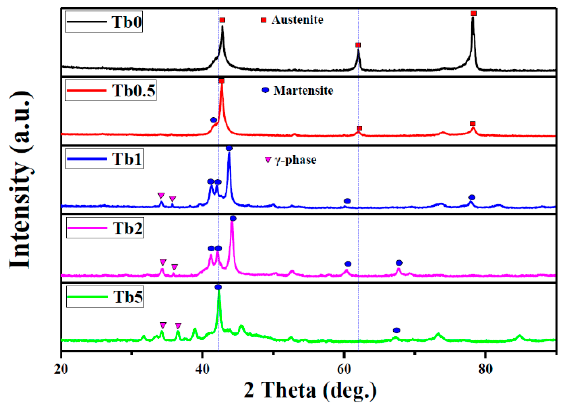
Figure 3. X-ray diffraction patterns of Ni 48 Mn 39 Sn 13 − x Tb x alloys.